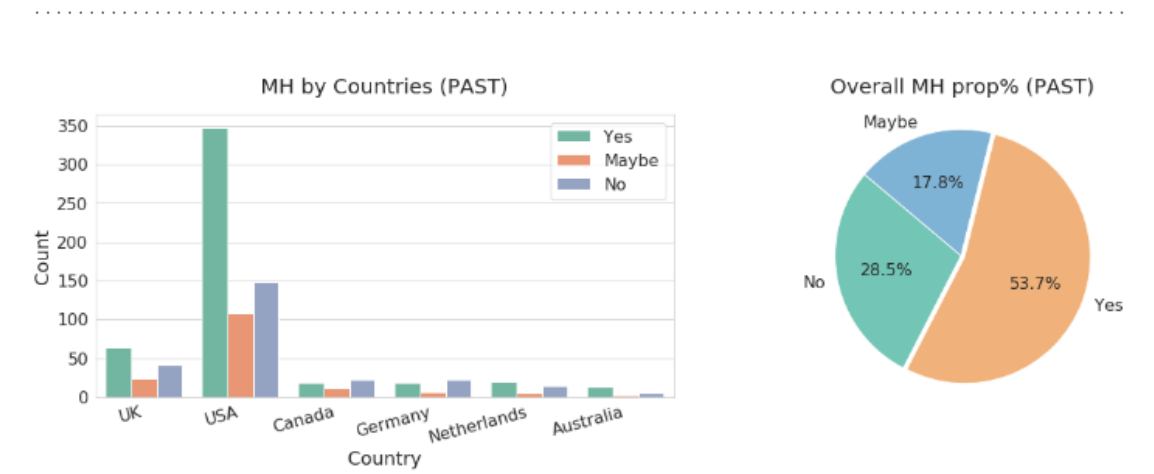
Figure 6: Mental Health Disorder in Tech with past overall percentage proportion